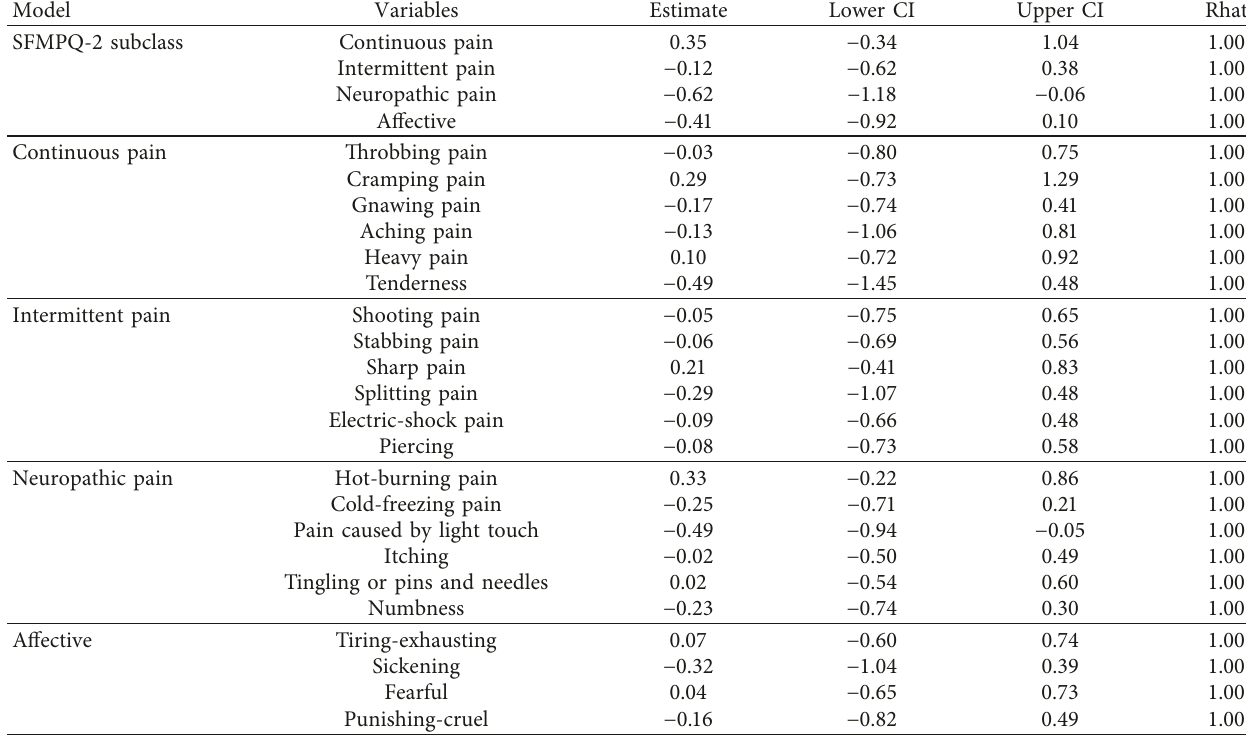
Table 2: GLMM regression results for relationship between muscle activity and pain intensity/quality.